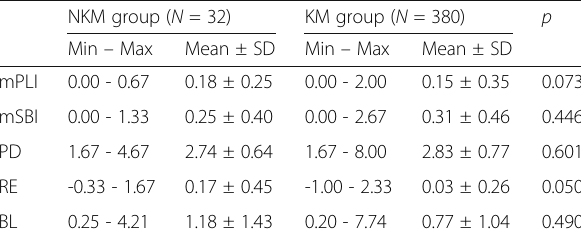
Table 2 Comparison of peri-implant clinical parameters between the NKM and KM group